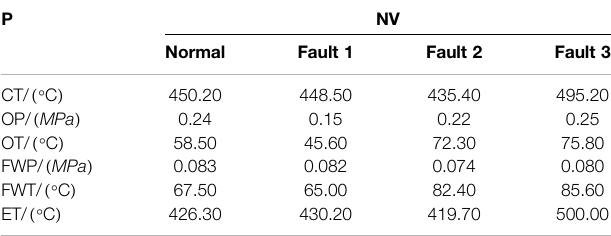
TABLE 1 | Normalized vector table in the states of health and three failure